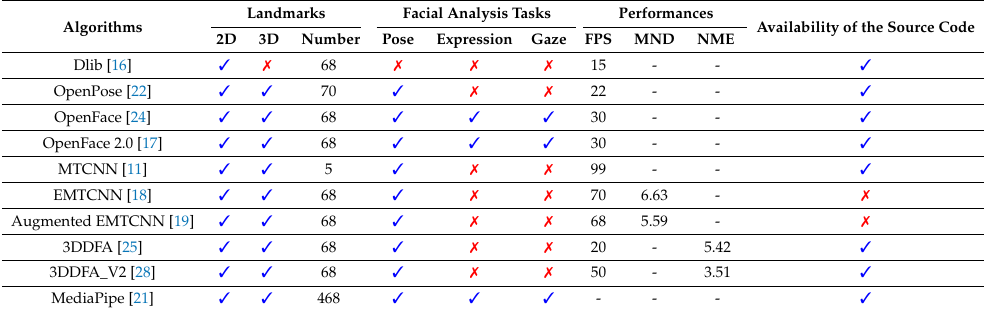
Table 1. Head pose estimation algorithms benchmarking. Performances are evaluated in terms of Frames Per Second (FPS), Mean Normalized Distance (MND) and Normalized Mean Error (NME).